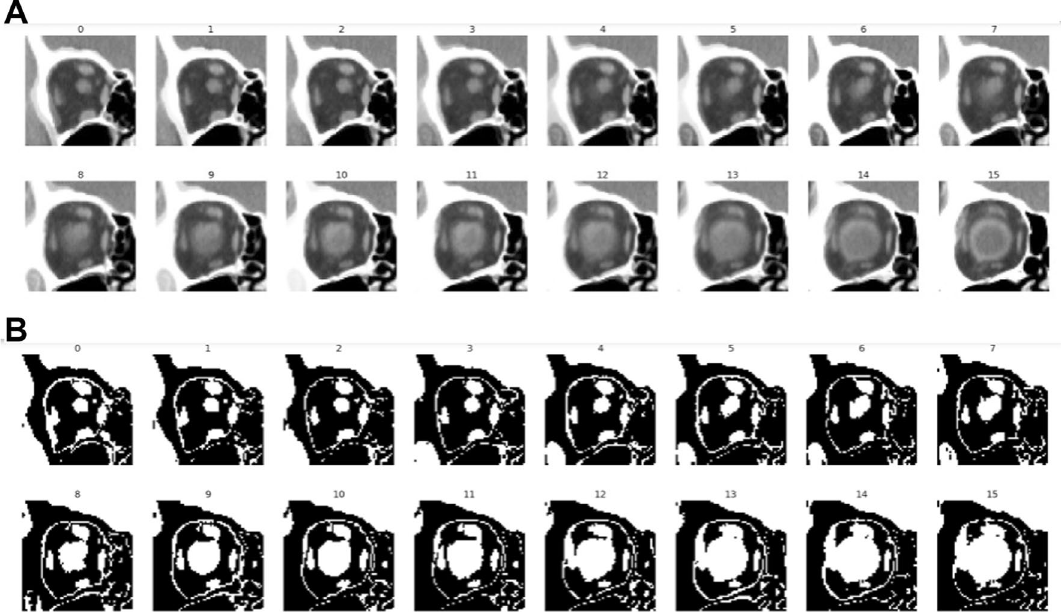
Figure 7. Representative partial CT image series ( A ) before and ( B ) after pixel value